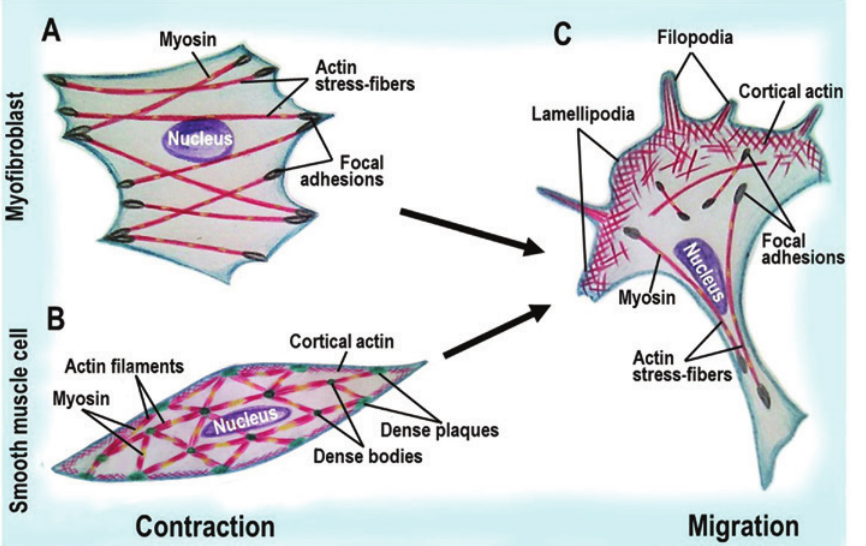
FIgure 1: Schematic diagram illustrating contraction vs. migration phenotype in fibroblasts and smooth muscle cells. (A) contractile fibroblasts, myofibroblasts, are characterized by the formation of myosin-containing actin contractile stress fibers. (B) in contracting smooth muscle cells, actin assembles into myosin-containing actin contractile apparatus and cortical actin network. (C) migration of both fibroblasts and smooth muscle cells is accompanied by a similar reorganization of actin microfilament system, including lamellipodia and filopodia